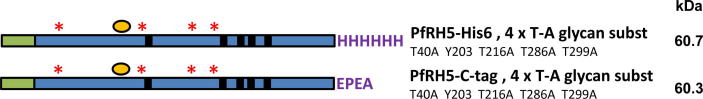
Plasmodium falciparum reticulocyte-binding protein homolog 5 vaccine constructs showing a schematic of P. falciparum reticulocyte-binding protein homolog 5 proteins. Both constructs encoded from the N-terminus: a BiP insect signal peptide (green) followed by the ectodomain of P. falciparum reticulocyte-binding protein homolog 5 (amino acids 26–526) (blue) followed by a C-terminal tag – either hexa-histidine or the glutamic acid – proline – glutamic acid – alanine C-tag. The proteins were based on the P. falciparum 7G8 strain sequence which has tyrosine (Y) at position 203 (and not cysteine as in the 3D7 clone reference genome sequence) (yellow circle). The other cysteine residues in P. falciparum reticulocyte-binding protein homolog 5 are indicated by small black boxes (C224, C317, C329, C345 and C351). Threonine (T) to alanine (A) substitutions to remove N-linked glycan sequons are indicated by red asterisks. The predicted molecular weight for each protein is indicated.